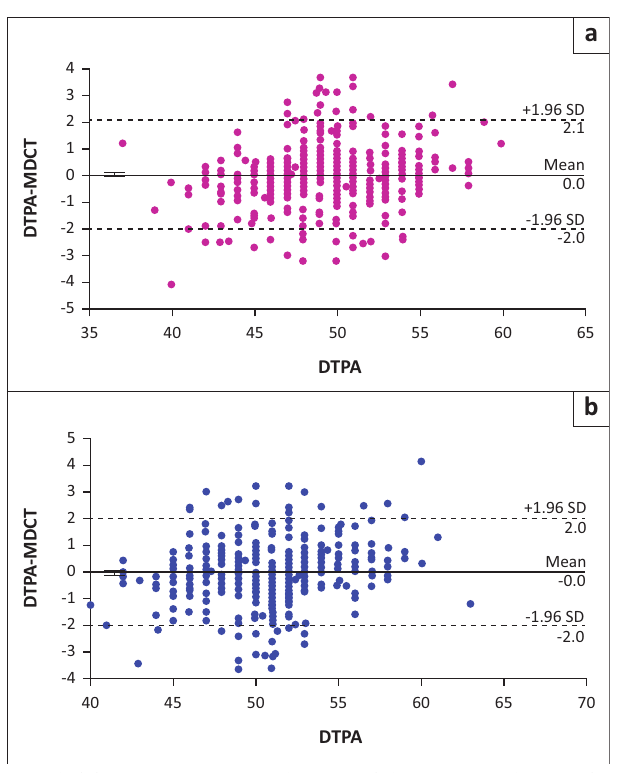
FIGURE 3 : The Bland Altman plot showing a strong linear relationship between diethylenetriaminepentaacetic acid and multidetector computed tomography measurements for (a) the left kidney and (b) the right